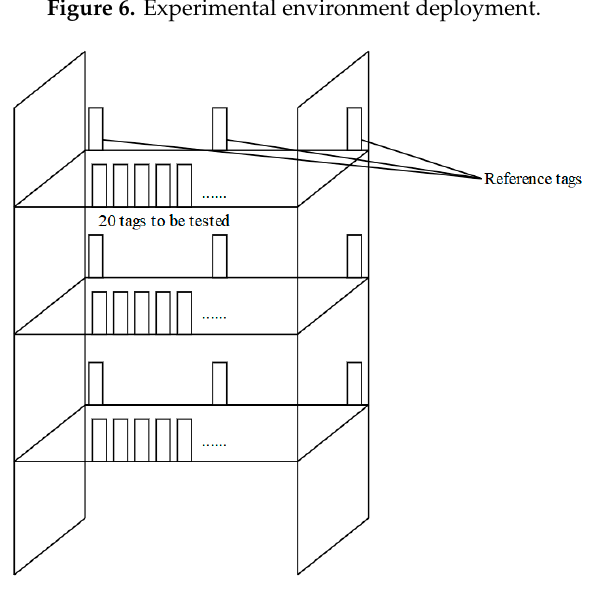
Figure 7 . Bookshelf deployment